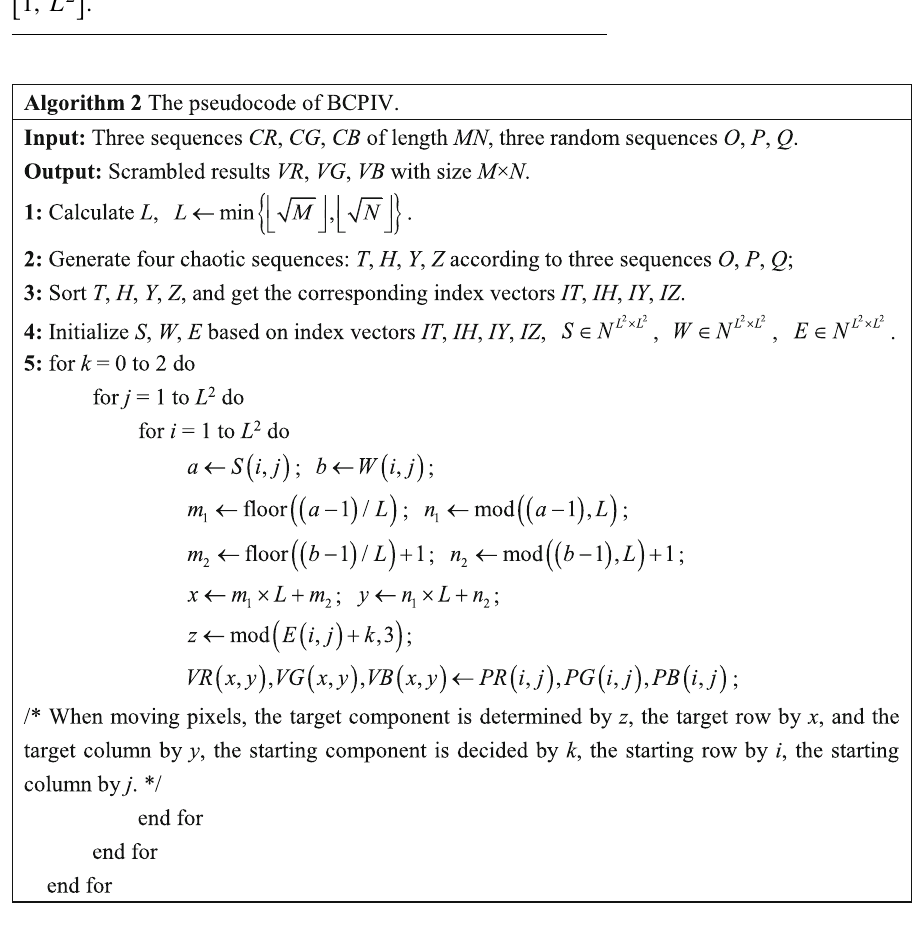
(cid:17) (cid:16) , and W ( i , j ) ∈ (cid:16) 1, L 2